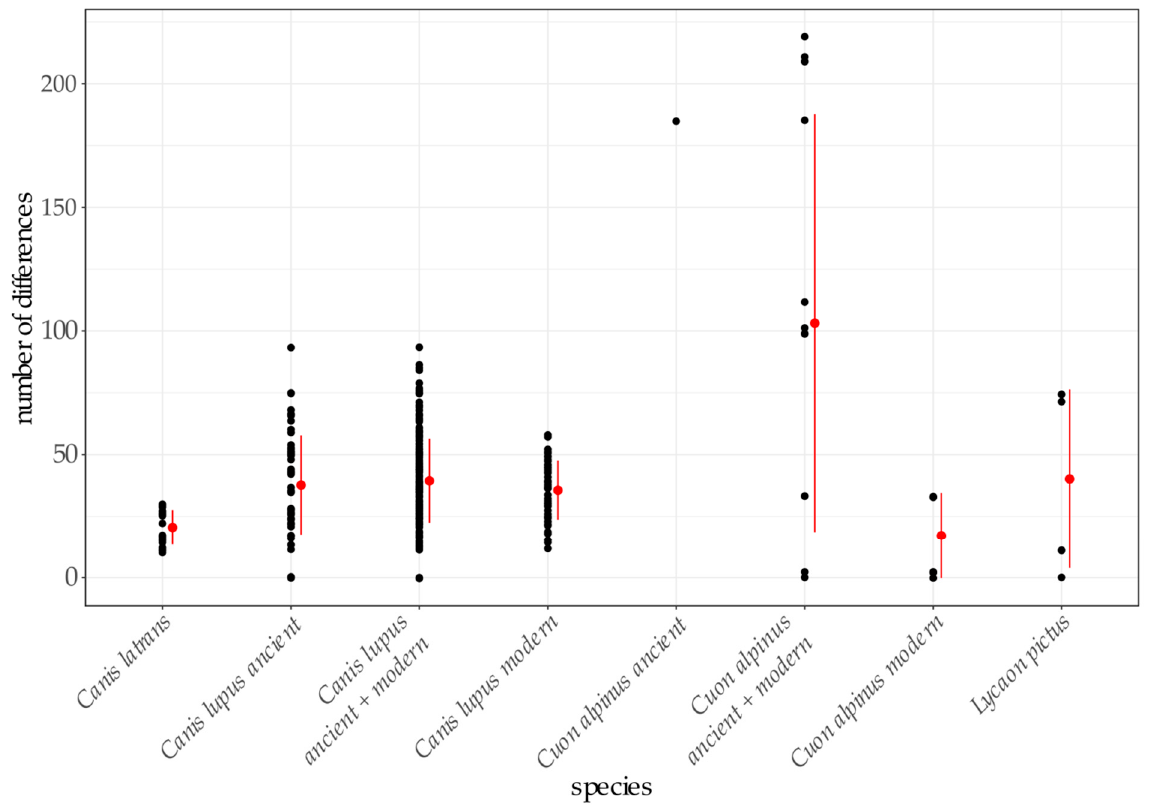
Figure 4. Pairwise differences as absolute number of differences between sequences for eight coyote, twelve ancient and ten modern gray wolf, two ancient and four modern dhole, and four African wild dog sequences are shown using MSAs of 10,582 bp length. Each black dot represents one pairwise comparison. Red dots are mean values and red lines indicate standard deviation.